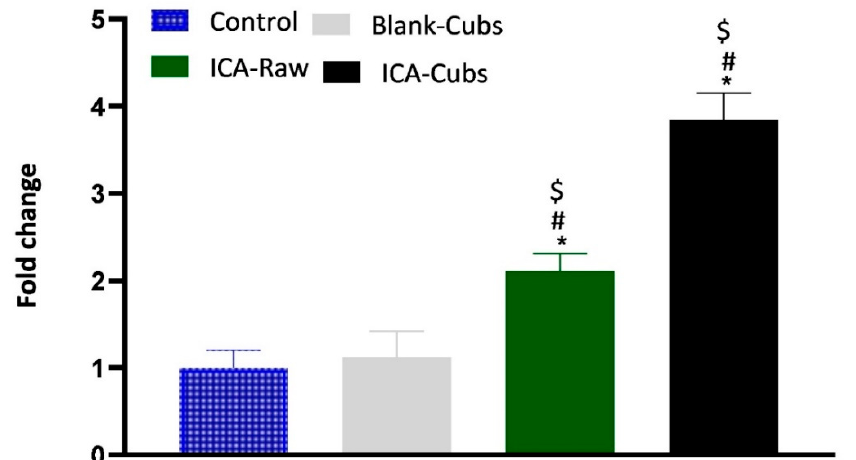
Figure 12. Decrease in the folds of TNF- α production in SKOV-3 cells following treatment with blank-Cubs, ICA-raw, and ICA-Cubs. Data are expressed as the mean ± SD (n = 4 runs). * represents a significant difference when compared with untreated cells (control) ( p < 0.05), whereas # represents a significant difference when compared with the blank-Cubs ( p < 0.05) and $ represents a significant difference when compared with the ICA-raw ( p < 0.05).